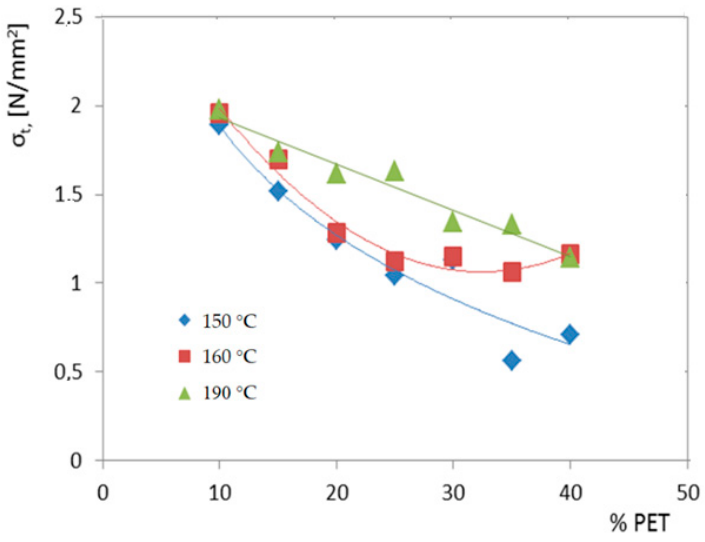
Figure 1. Variation of tensile strength with % PET and processing temperature. The tensile strength of the all-waste composite drastically decreased when the PET content was increased due to the weakening interface with PET particle agglomerations, Figure 1. The agglomeration of PET at the interface zone hampers the stress transfer from the matrix to filler, as tensile strength tests have revealed. The highest tensile strength was recorded to be 10 wt% for the PET composites. That is why in developing novel composites with rubber, HDPE, wood, and fly ash 10% wt PET was considered. Five representative samples (with fly ash) of each series (before and after water immersion) were mechanically tested, and the average values are summarized in Table 2. Table 2. Mechanical properties of composites with PET, rubber, HDPE, wood, and ash addition, before and after the water immersion.